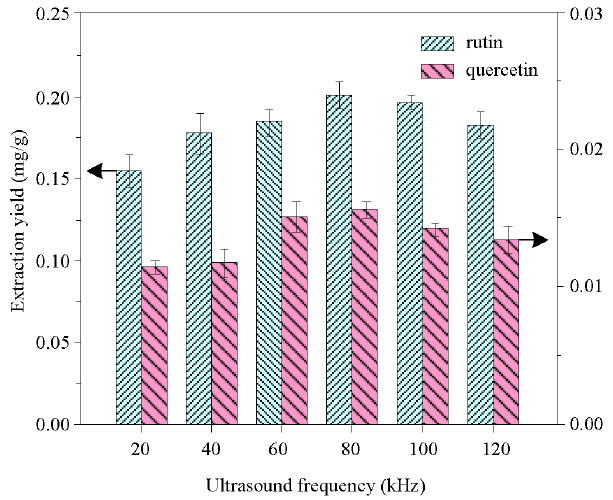
Figure 8. Effect of ultrasound frequency using 60% concentration of ethanol solution with 40 mL/g of ratio at 30 °C and 200 W for 30 min on the extraction of quercetin and rutin.